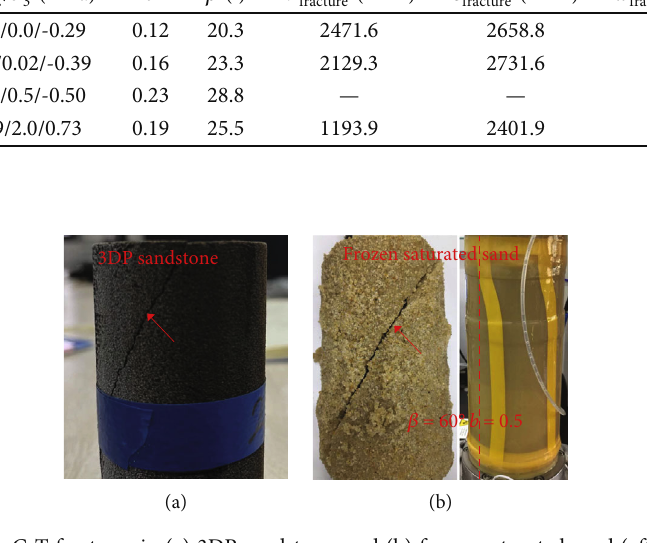
Figure 14: C-T fractures in (a) 3DP sandstone, and (b) frozen saturated sand (after [44]).